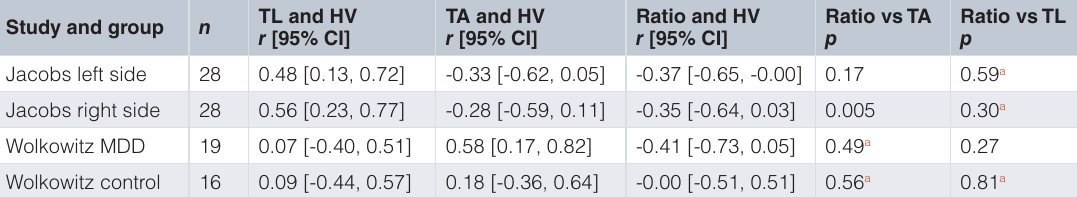
Table 2. Comparisons of the ratio of telomerase to telomere length as predictor of hippocampus volume to either measure alone. Data from Jacobs et al. 13 were estimated from published scatterplots showing only the APOE ∈ 4-negative participant subset, separately for right and left hippocampus, and are adjusted for age. Further adjustments for education and BMI were not possible because data were not available. Data from Wolkowitz et al. 21 were estimated from published scatterplots and are not adjusted for any covariates. Adjustments for age and sex were not possible because data